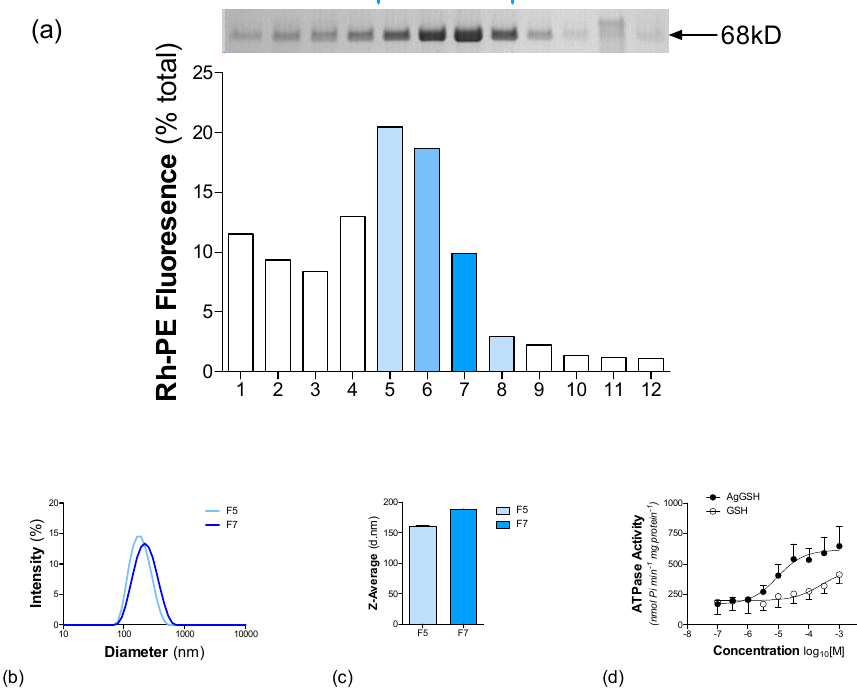
Figure 6. Effectiveness of reconstituting NaAtm1 into hybrid polymersomes. NaAtm1 was reconstituted into hybrid vesicles containing 50 mol% of each of PBd-PEO and POPC using detergent (DDM) adsorption. The success of reconstitution was assessed using sucrose density (0%–40% (w/v)) centrifugation (100,000 g, 18 h, 4 °C). Vesicles contained a small proportion (0.1 mol %) of the lipid probe Rh-PE. ( a ) The presence of Rh-PE fluorescence ( λ ex = 560 ± 5 nm and λ em = 583 ± 5 nm) was monitored in each fraction collected from the gradient. The presence of NaAtm1 was detected in each fraction of the gradient using SDS-PAGE with AcquaStain Protein Gel Stain. The protein fractions ( upper panel ) were placed above their respective position within the sucrose gradient. ( b ) DLS intensity profiles measured for fractions F5 and F7 obtained from the sucrose density gradient. ( c ) The Z-average of the intensity profiles, used to estimate the hydrodynamic size of the vesicles. ( d ) The substrate stimulated ATPase activity was measured following reconstitution of NaAtm1 into hybrid vesicles of PBd-PEO (50 mol%) and POPC (50 mol%). ATPase activity was measured in the presence of a fixed amount of ATP (2 mM) and varying concentrations (10 − 7 –10 − 3 M) of Ag-GSH ( ● ) or GSH ( ○ ). Values represent the mean ± SEM obtained from three independent preparations and data were fitted by non-linear regression of the general dose-response Equation (2).